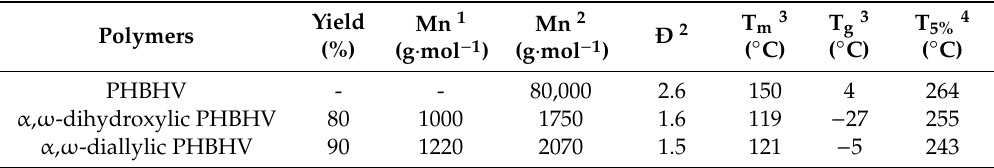
Figure 2. 1 H NMR spectrum (400 MHz, CDCl 3 ) of the α , ω -diallylic PHBHV oligomers. Table 1. Characteristics of the PHBHV